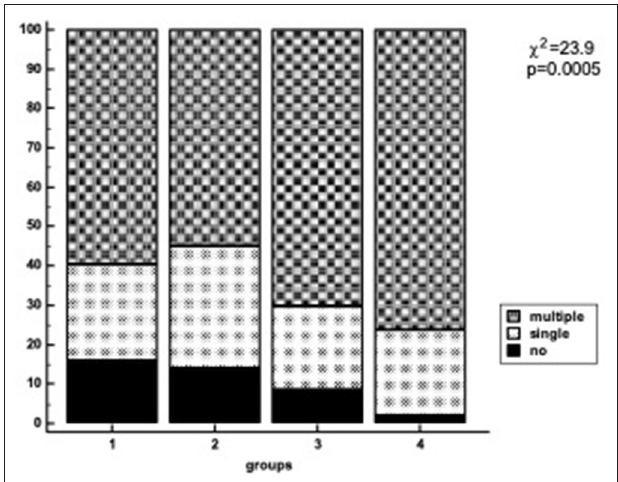
FIGURE 2 | Number of diseased coronary vessels in different groups of patients regarding Lp(a) levels and apo(a) phenotype. Lp(a), lipoprotein(a); Group1, HMW apo(a) and Lp(a) < 50 mg/dL; Group 2, HMW apo(a) and Lp(a) ≥ 50 mg/dL; Group 3, LMW apo(a) and Lp(a) < 50 mg/dL; Group 4, LMW apo(a) and Lp(a) ≥ 50 mg/dL; LMW apo(a), low-molecular weight apo(a) phenotype; HMW, high-molecular weight apo(a)